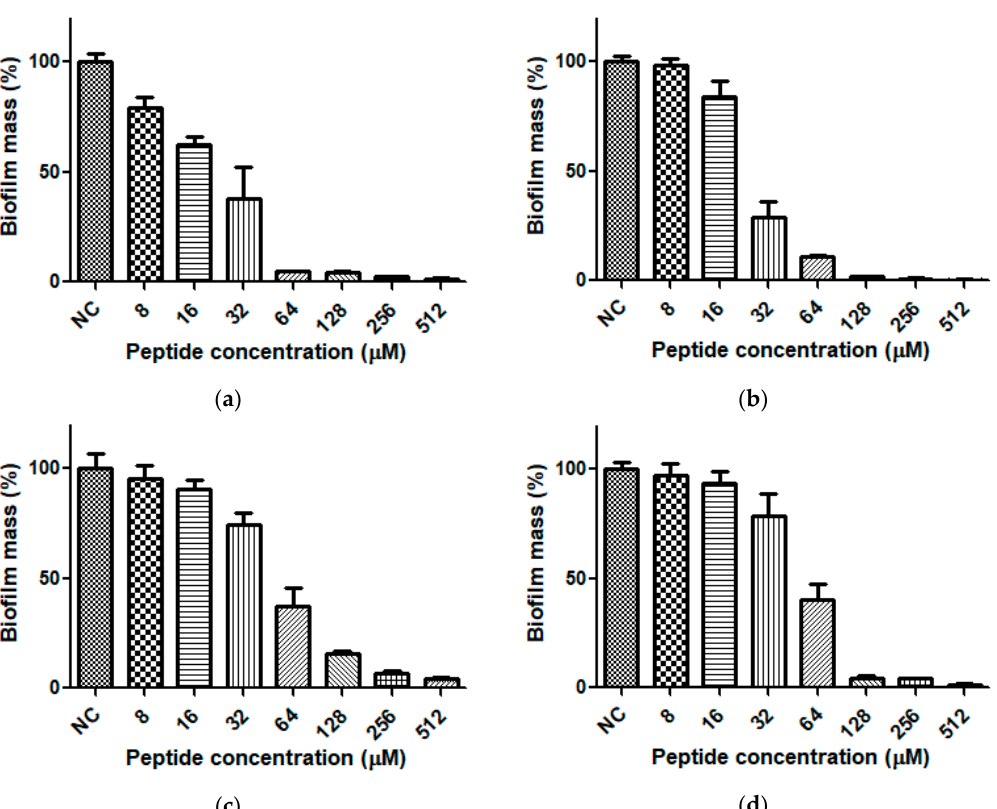
Figure 9. The biofilm formation inhibitory activity of Dermaseptin-PH against ( a ) E. coli and ( b ) S. aureus , and the biofilm eradication activity of Dermaseptin-PH against ( c ) E. coli and ( d ) S. aureus . Negative control was obtained following incubation with relevant culture medium. Data represent means ± SEM of 5 replicates.